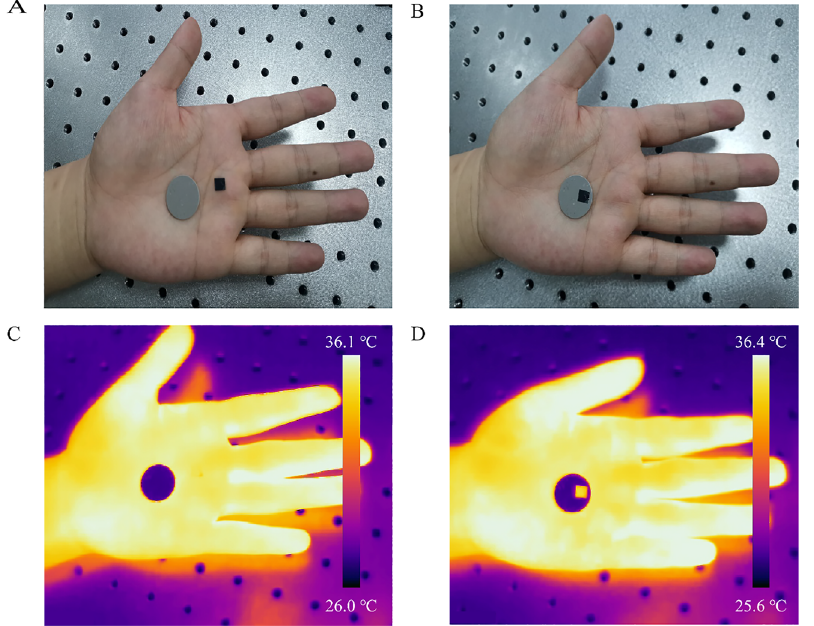
Figure 6: Infrared camouflage demonstration. (A, B) Photographs of the LWIR absorber on the human hand and Ag mirror, respectively. (C, D) Infrared images corresponding to (A) and (B), respectively, acquired using an infrared camera (detection wavelength: 8 – 14 μ